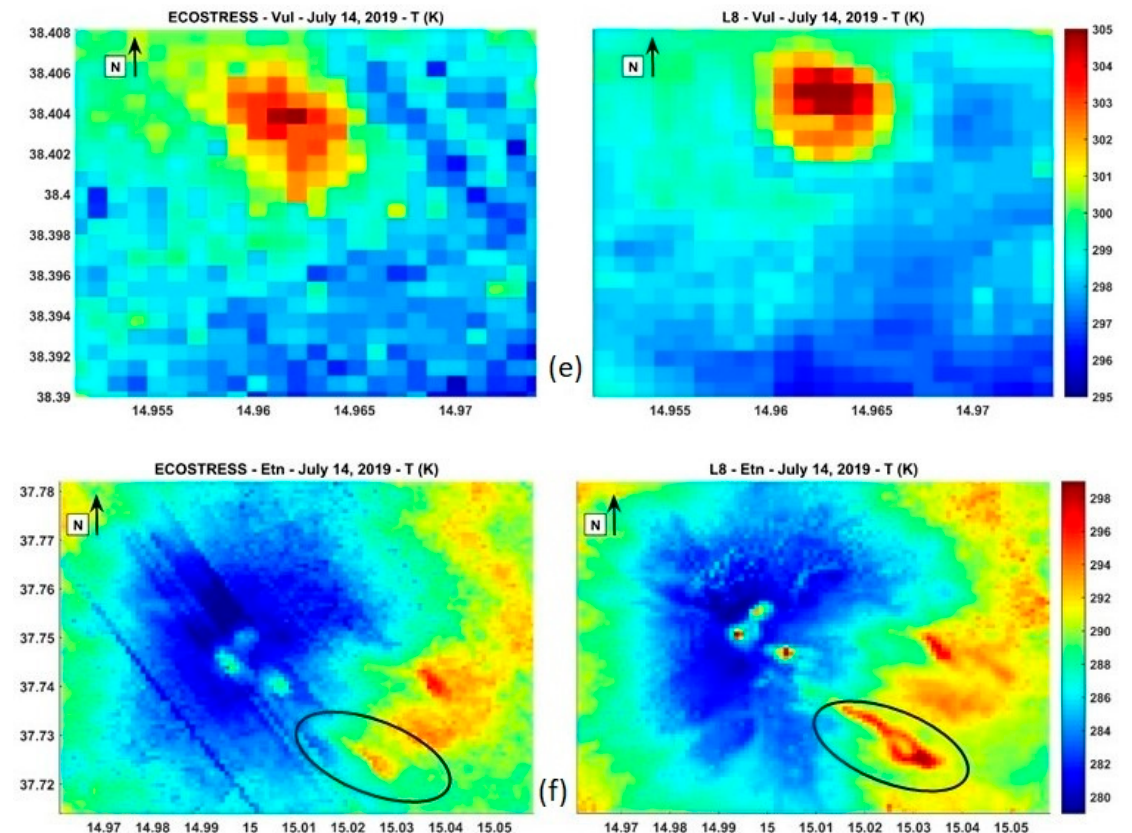
Figure 2. Surface temperature estimates by ECOSTRESS ( left ) and L8 data ( right ) at Parco delle Biancane ( a ), Solfatara ( b ), Vesuvio ( c ), Stromboli ( d ), Vulcano ( e ), Etna ( f ). North is aligned with the vertical axis and the pixel size is 90 m. In the oval, the lava flow which occurred during the eruption is highlighted.